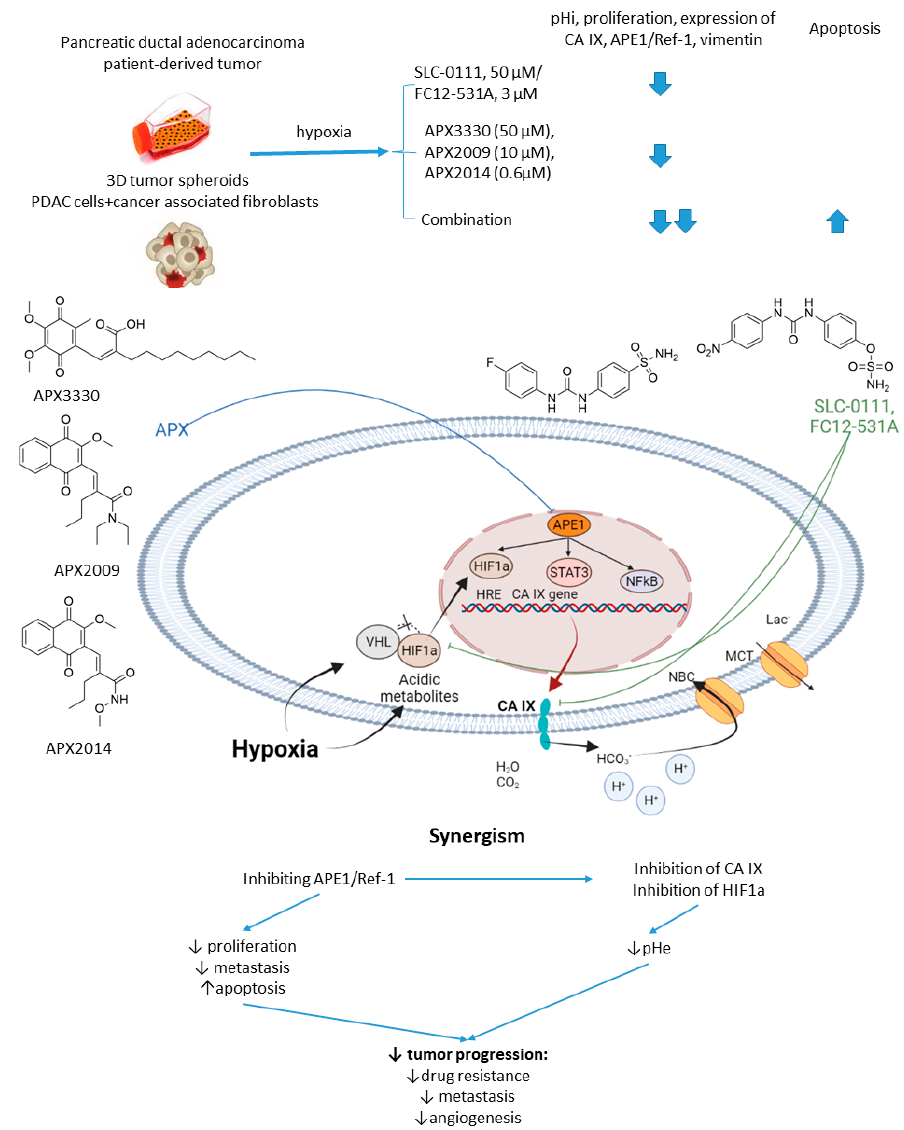
Figure 15. Graphical outline of the study on SLC-0111/FC12-531A+APX3330/APX2009/APX2014 combination reported by Logsdon et al., and summary on the hypothesized molecular interactions resulting in synergistic action of the drugs [84].